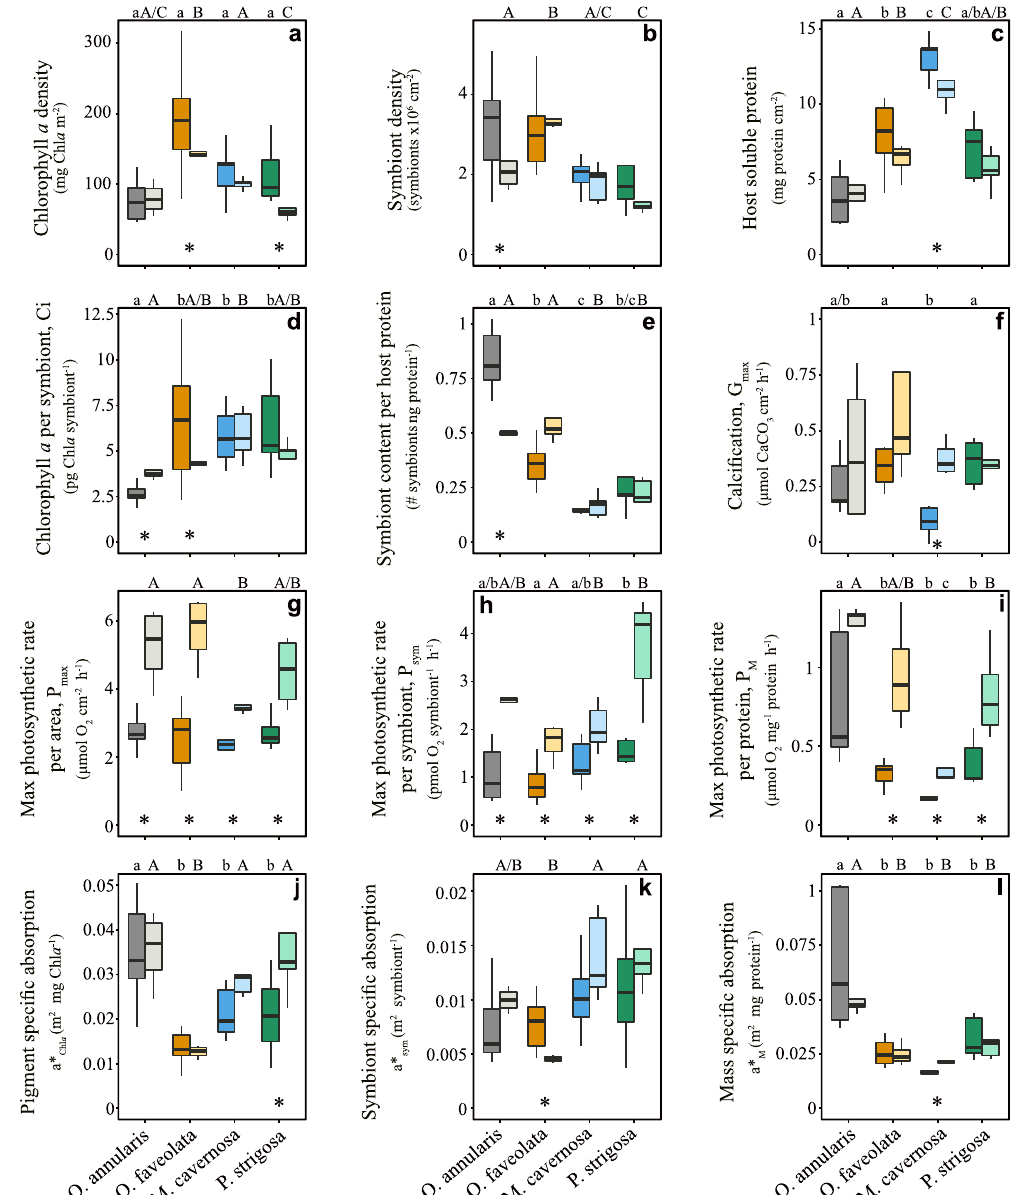
Figure 2. Characterization of winter and summer coral phenotypes. Box plots describing the variability of the different descriptors used in this study to characterize both winter (dark color) and summer (light color) phenotypes of Orbicella annularis (grey), Orbicella faveolata (orange), Montastraea cavernosa (blue), and Pseudodiploria strigosa (green). Boxes encompass the 25 and 75% quartiles of all the data. The central line corresponds to the median, and bars extend to the 95% and 5% of the confidence limits. Asterisks indicate significant differences (t-test, p < 0.05) between phenotypes within